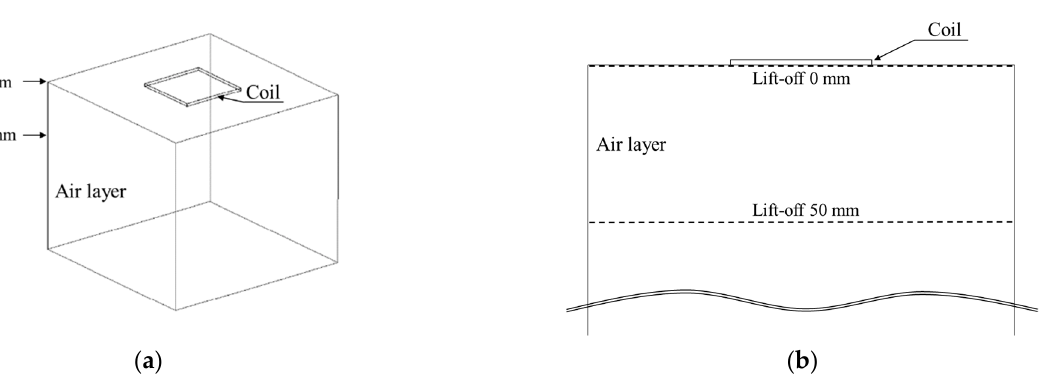
Figure 3. Photograph of the computer-aided wireframe design model (these models show a 100-mm² coil): ( a ) whole image and ( b ) cross-sectional image.